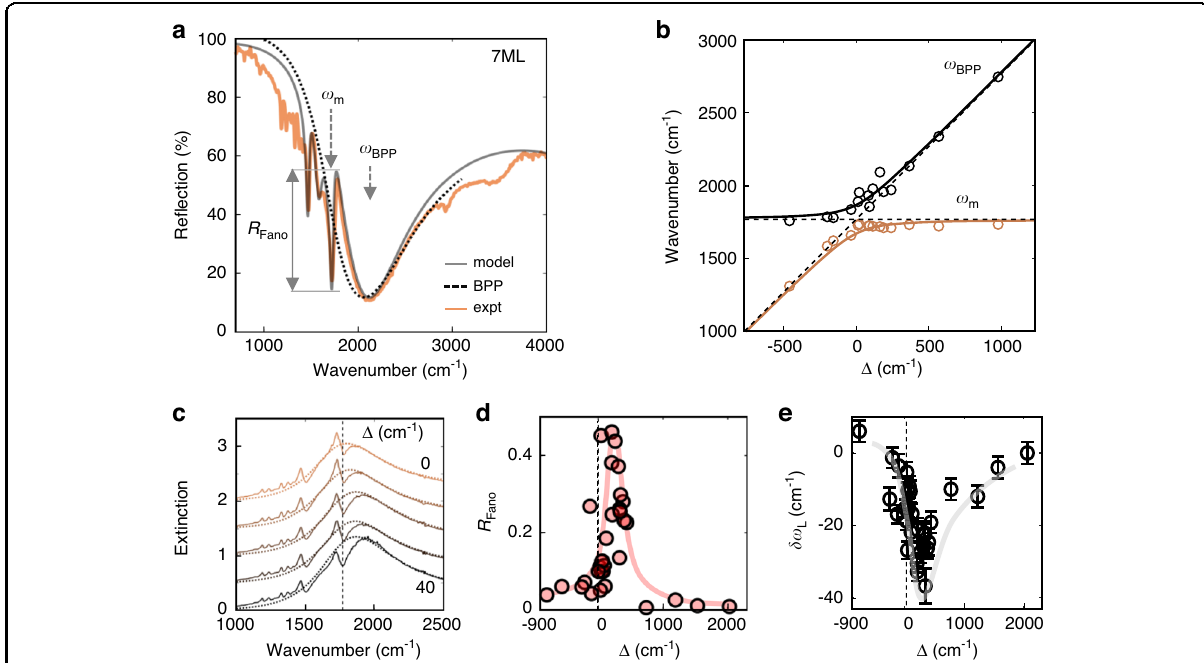
Fig. 3 Vibrational-plasmon coupling. a Fano lineshape of CB[5] vibration in coupled oscillator model fi t ( ‘ model ’ , black line, SI Section S3) to the measured re fl ectance spectrum ( ‘ expt ’ , blue line) of NP7ML-on-mirror fi lms. b Extracted coupled plasmon-vibrational modes show an anticrossing with coupling strength g ~ 100 cm − 1 . c Extinction for detunings around resonance, showing phase change of Fano dip. d Fano dip strength R Fano of the SEIRA molecular absorption at 1765 cm − 1 and e molecular Lamb shift δω L vs plasmon-molecular vibration detuning Δ = ω BPP − ω m between molecular ( ω m ) and plasmon ( ω BPP ) resonances (lines are guides to